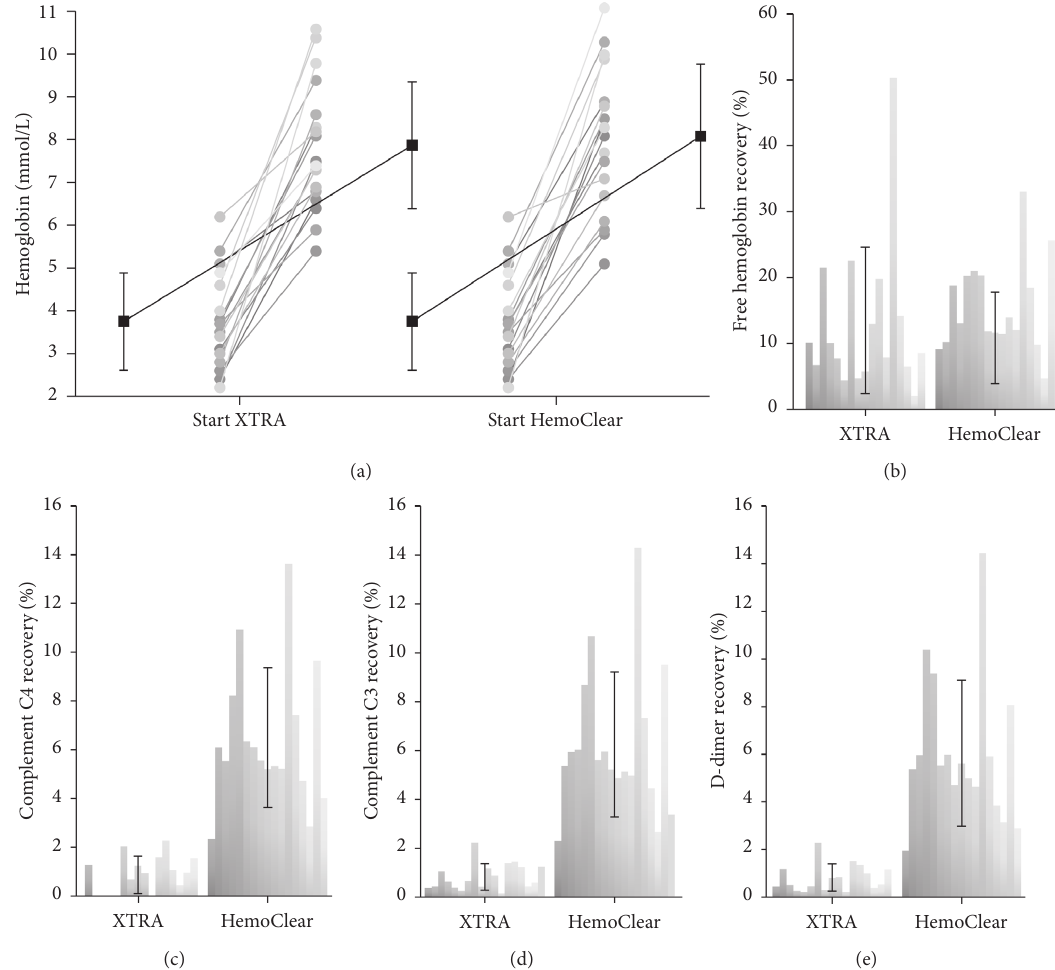
Figure 7: (a) Hemoglobin concentration in concentrates of XTRA ™ cell saver and HemoClear before and after washing. Black lines indicate mean values, error bars represent standard deviation. (b–e) Percentage of total load recovered in concentrates of the XTRA ™ and HemoClear device. Each bar represents an individual sample, error bars indicate standard deviation. (b) Free hemoglobin recovery. (c) Complement C4 recovery. (d) Complement C3 recovery. (e) D-dimer